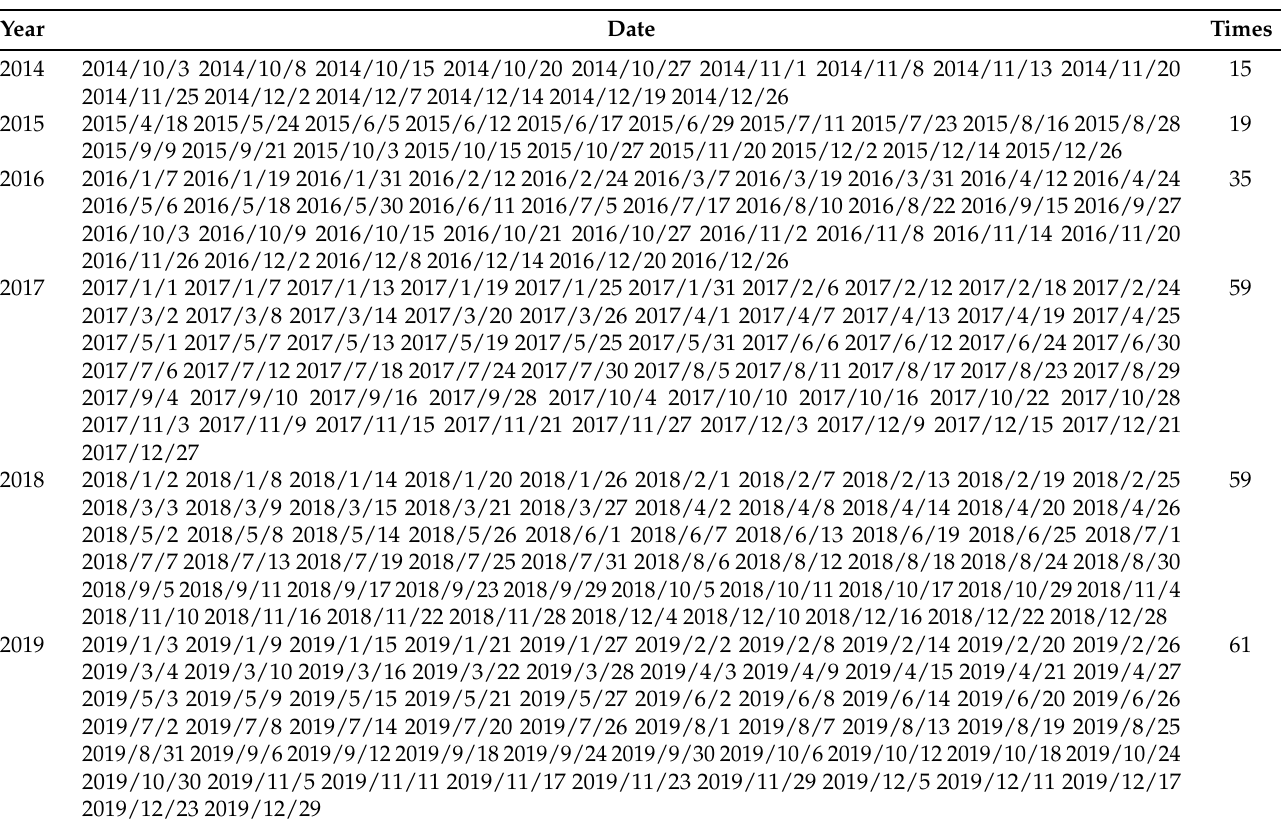
Table A1. The observation date and times for different years in this